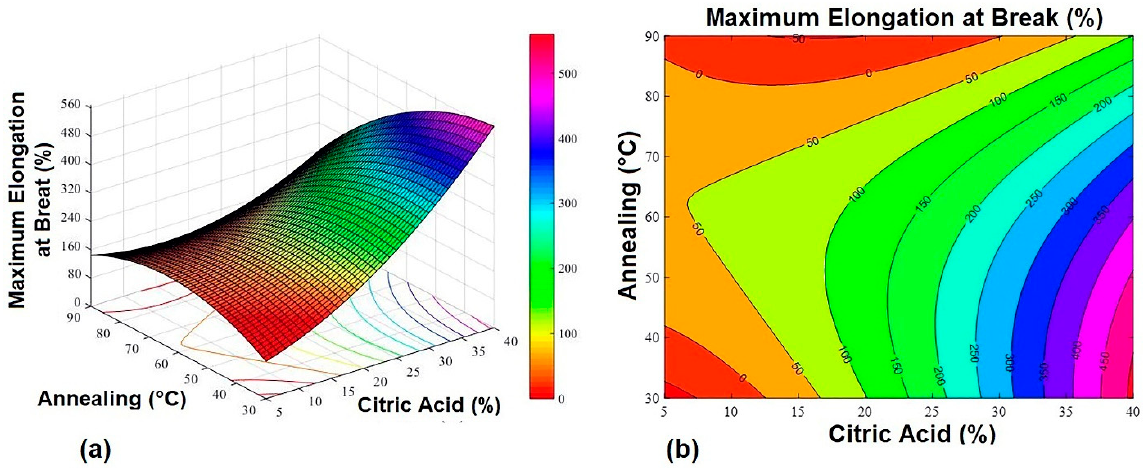
Figure 3. Maximum elongation at break response surface graphs. ( a ) 3D response surface graph and ( b ) contour plot.